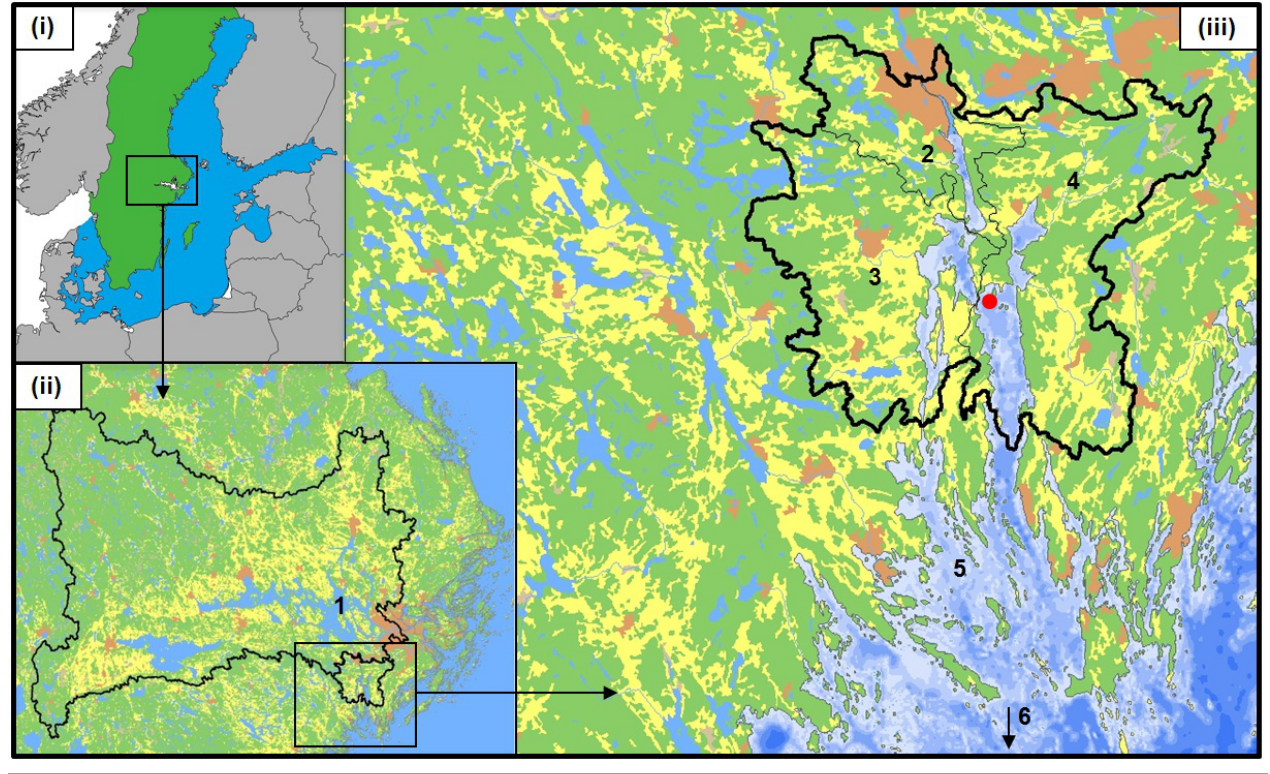
Fig. 1 . Location of the study site: (i) Sweden, located in the Baltic Sea; (ii) the Swedish Northern Baltic Sea River Basin District, including Lake Mälaren (1); and (iii) the Himmerfjärden study site area; divided in the model areas “Hallsfjärden” (2), “Näslandsfjärden” (3), and "Himmerfjärden proper" (4). Via "Svärdsfjärden” (5) the study site area is connected to the open Baltic Sea (6). The red circle in "Himmerfjärden proper" is the discharge point of the Himmerfjärden sewage treatment plant. The colors in the study site map indicate: blue = water (dark is deeper for marine areas), green = forest, yellow = arable land, orange = urban area. ©Lantmäteriet, permission I